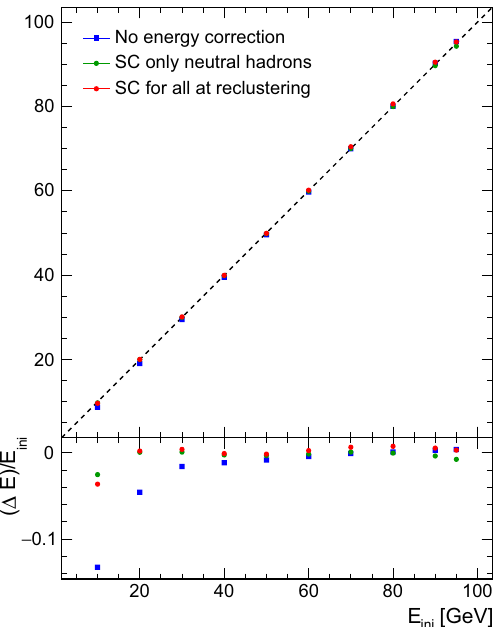
Fig. 5 Mean reconstructed energy for single neutrons and K 0 the sum of all PFOs: without energy correction (blue), when applying SC to neutral clusters at the PFO level (green) and when applying SC also during pattern recognition for all clusters (red). The dashed line shows the E reco = E ini relationship